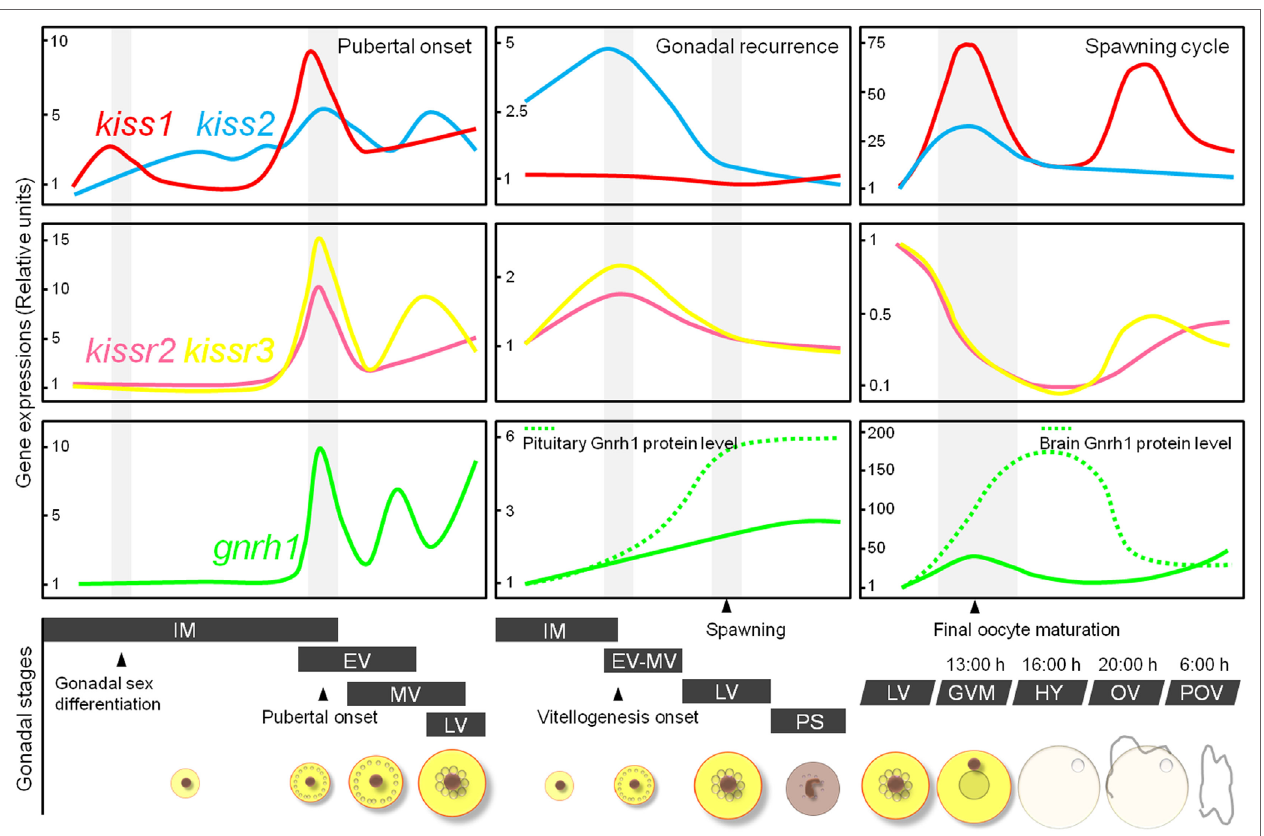
FigURe 4 | Schematic representation showing relative changes in kiss1 , kiss2 , kissr2 , kissr3 , and gnrh1 gene levels in the brain of female chub mackerel during the puberty, gonadal recurrence, and spawning cycle. Abbreviations: IM, immature; EV, early vitellogenesis; MV, mid-vitellogenesis; LV, late vitellogenesis; GVM, germinal vesicle migration; HY, hydration; OV, ovulation; POV,